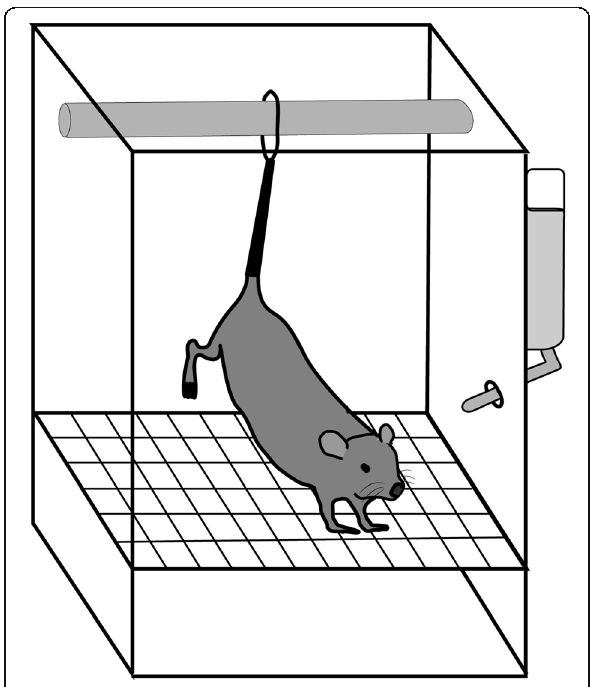
Fig. 2 Tail suspended mouse model. A model in which the tail of a mouse is suspended to release the hind limbs from mechanical load